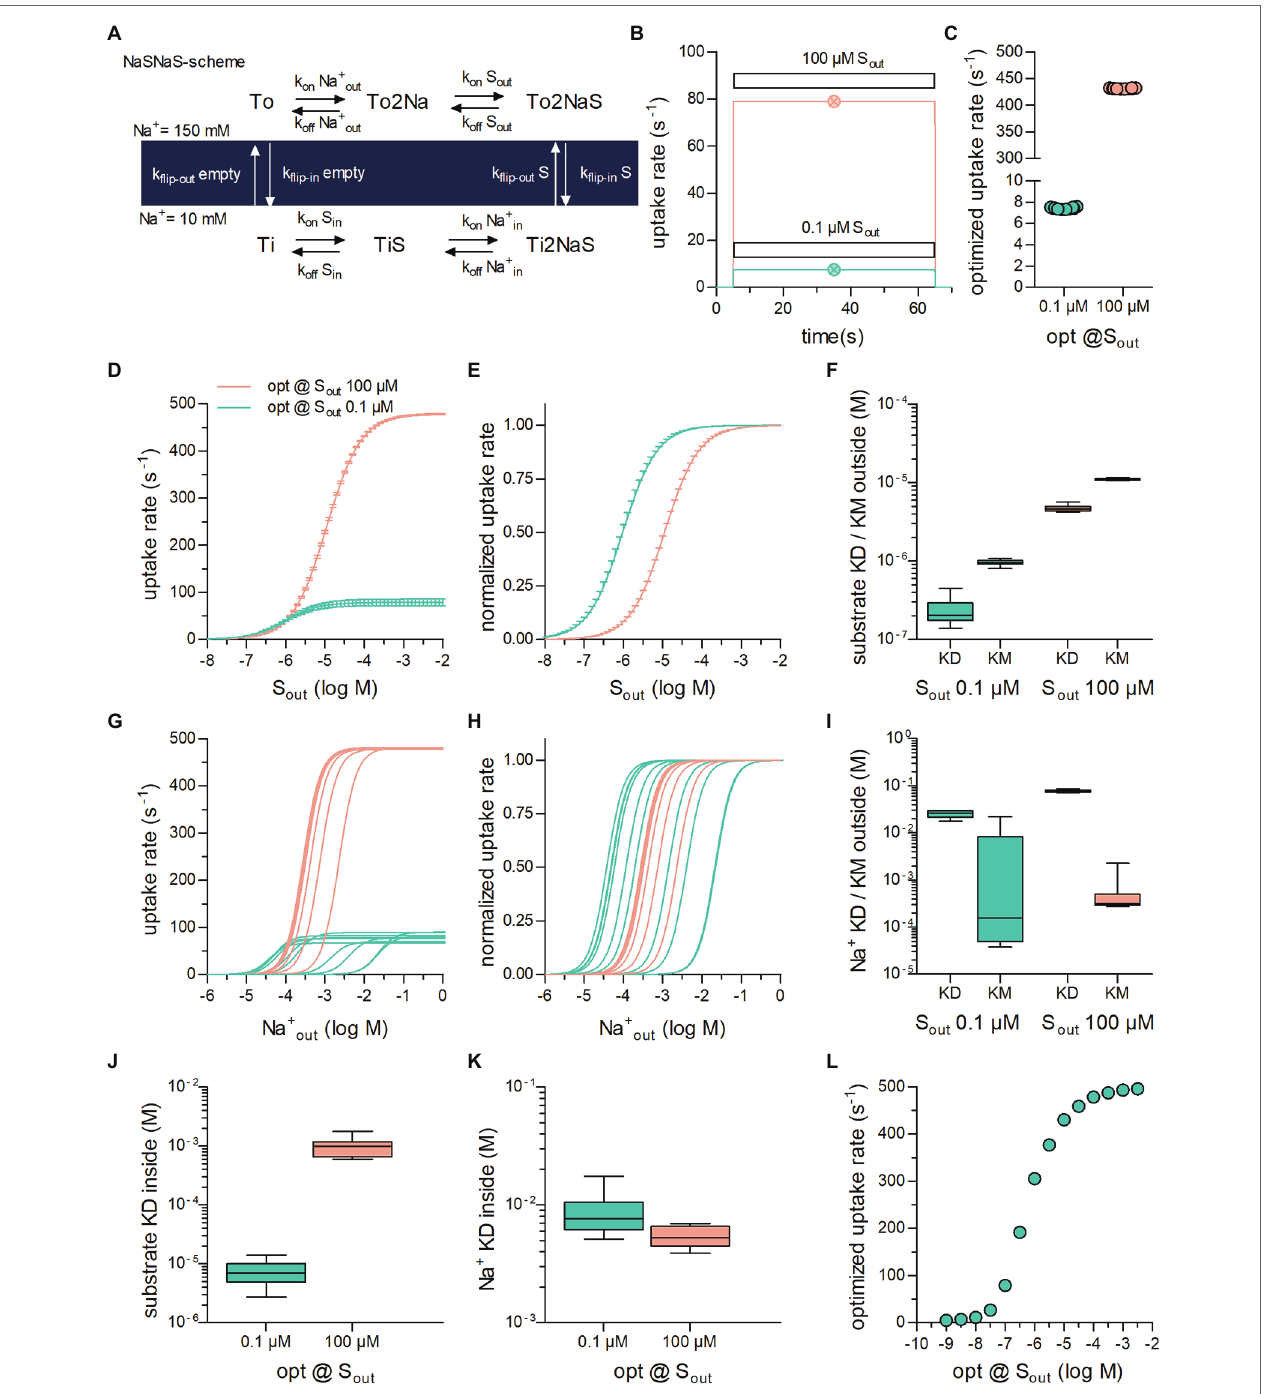
FIGURE 1 | Optimization of secondary active transporters operating in a sequential binding mode for translocation of substrate at a low and high concentration. (A) Reaction scheme of a Na + symporter in the sequential binding mode (“first in, first out”) referred to as NaSNaS: The apo-outward-facing transporter (To) first binds two Na + ions (To2Na). On substrate binding, (To2NaS) the transporter rearranges to adopt the inward-facing conformation (Ti2NaS). Subsequent to the release of its cargo into the cytosol (TiNa2S → TiS → Ti) the substrate-free inward-facing transporter (Ti) undergoes a conformational change upon which the transporter returns to To. (B) Simulated substrate uptake rate of the symporter operating according to the scheme outlined in (A) after application of .1 μ M (green trace) and 100 μ M (magenta trace) of substrate (S out ). For this simulation the microscopic rate constants (i.e., k on Na + out and k flip-in S) were parameterized with the values for the optimized transporter T1 shown in Table 1 . The symbols in green and in magenta show the substrate uptake rates computed for T1 with the analytical expression (see supplement) for .1 μ M and 100 μ M S out , respectively. The uptake rates obtained with the two different approaches were identical. (C) Substrate uptake rates of